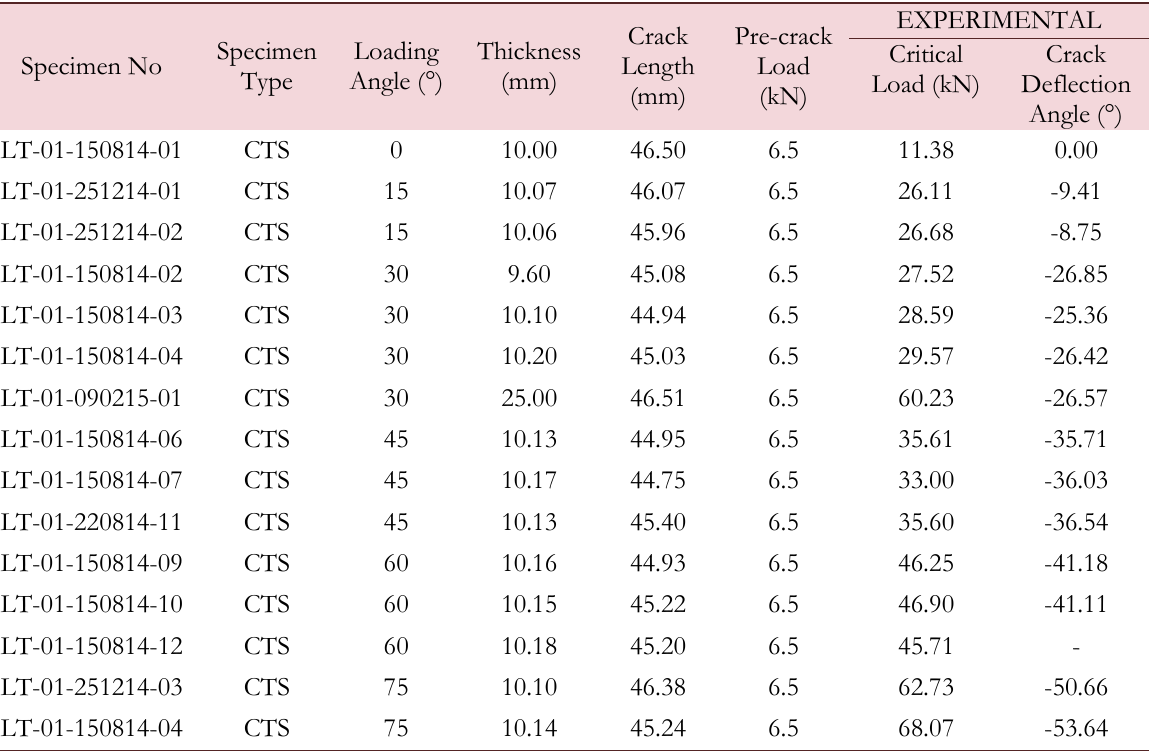
Table 1: Experimental results of CTS specimen obtained from the mixed mode fracture tests. Results of T-Specimen Experiments